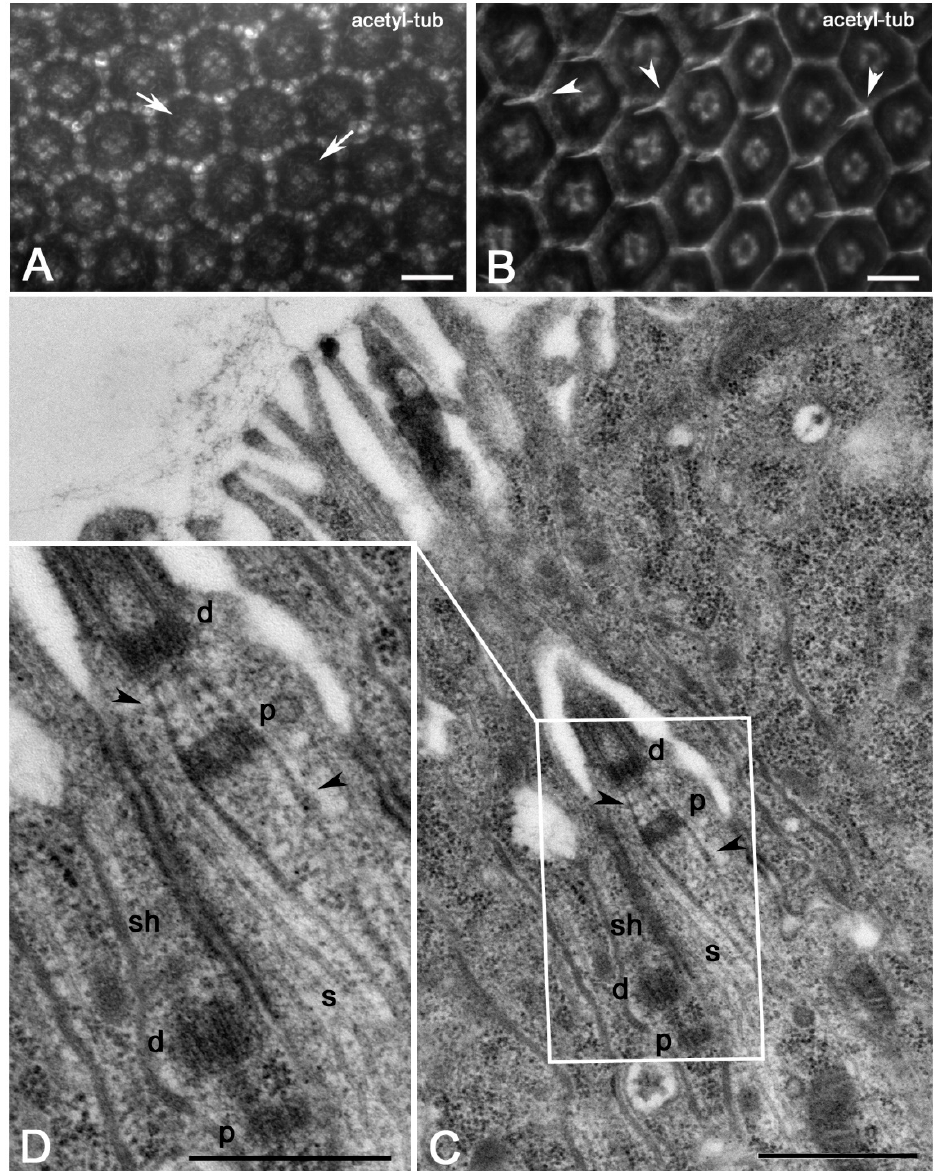
Figure 1. Surface view of the wild-type Drosophila retina at 25 h ( A ) and 45 h ( B ) after puparium formation (APF): At 25 h APF the interommatidial cells are disposed in a precise hexagonal pattern around the four cone cells of each ommatidium (arrows); after 45 h APF the interommatidial cells flattened and distinct mechanosensory bristles are visible at the apex of each ommatidial unit (arrowheads). Longitudinal sections of a wild-type mechanosensory bristle ( C ) and magnification of its basal region ( D ): tandemly aligned centrioles are present in both the sensory (s) and sheath (sh) cells; (d) distal and (p) proximal centrioles, arrowheads point to rootlets. Scale bars: 10 µm ( A , B ), 500 nm ( C , D ).